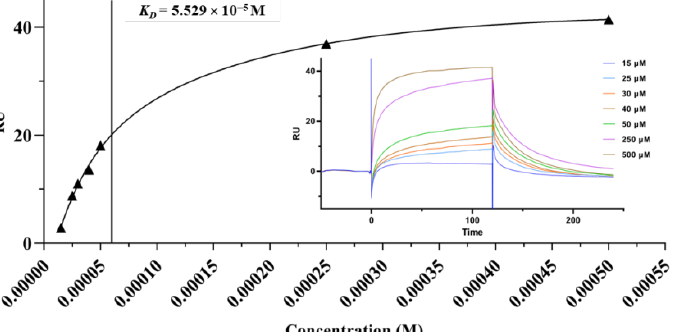
Figure 2. Binding kinetics and affinity of α -glucosidase to BA by SPR assay. Sensorgram showing the binding of BA at different concentrations to α -glucosidase was included.